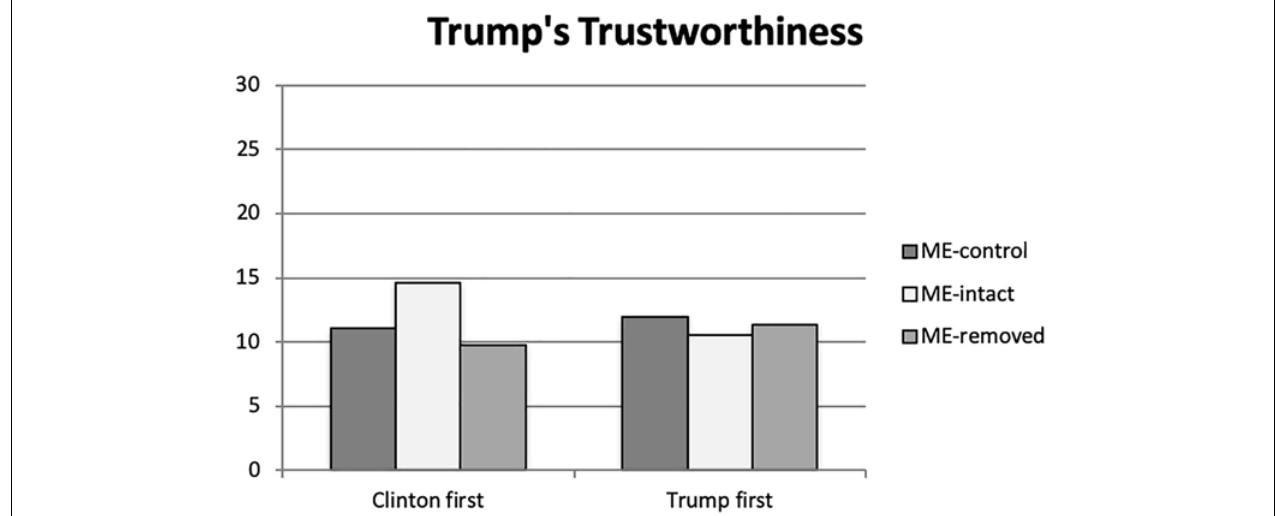
FIGURE 2 | Donald Trump’s perceived trustworthiness by Study 1